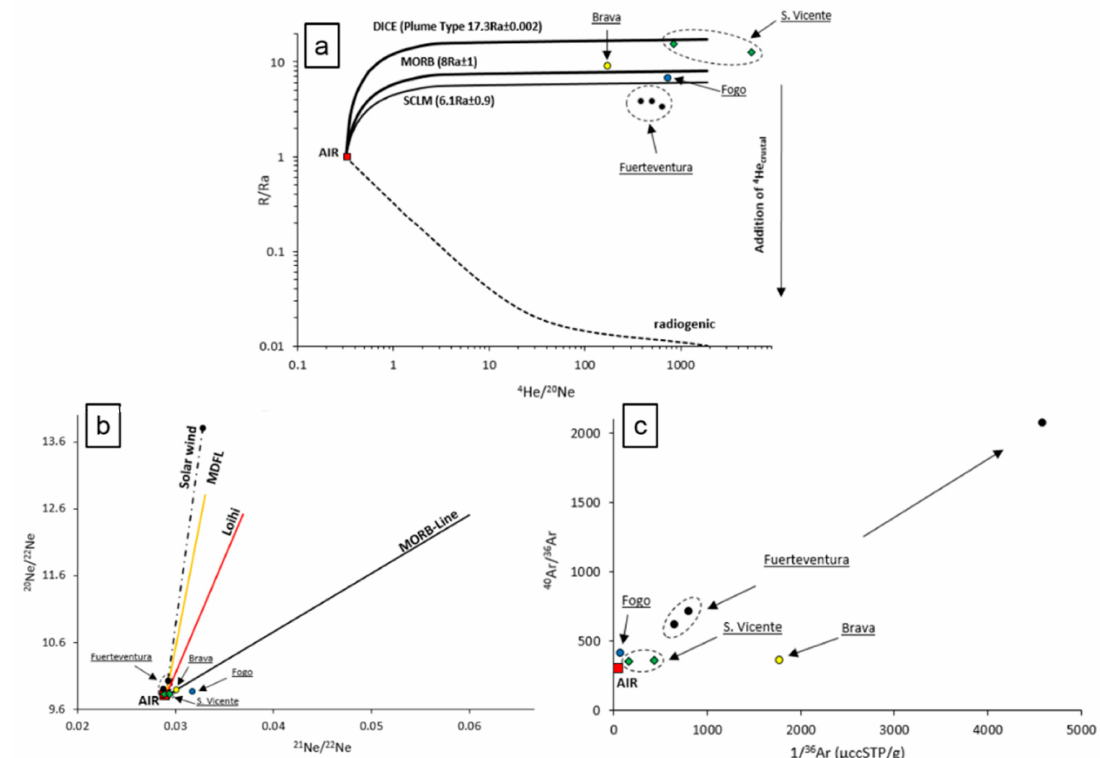
Figure 8. ( a ) R/Ra ratios vs. 4 He/ 20 Ne ratios obtained by crushing calcite in Fuerteventura and Cape Verde carbonatites. ( b ) 20 Ne/ 22 Ne vs. 21 Ne/ 22 Ne and ( c ) 40 Ar/ 36 Ar vs 1/ 36 Ar diagram from the same samples. Data from the Cape Verde islands are from Mata et al. 2010 [23]. Mixing lines in the 20 Ne/ 22 Ne vs 21 Ne/ 22 Ne diagram are from Broadley et al. 2020 [109]. The 20 Ne/ 22 Ne and 21 Ne/ 22 Ne air ratio is taken from Ozima and Podosek, 2002 [73], while the 40 Ar/ 36 Ar air ratio is taken from Lee et al. 2006